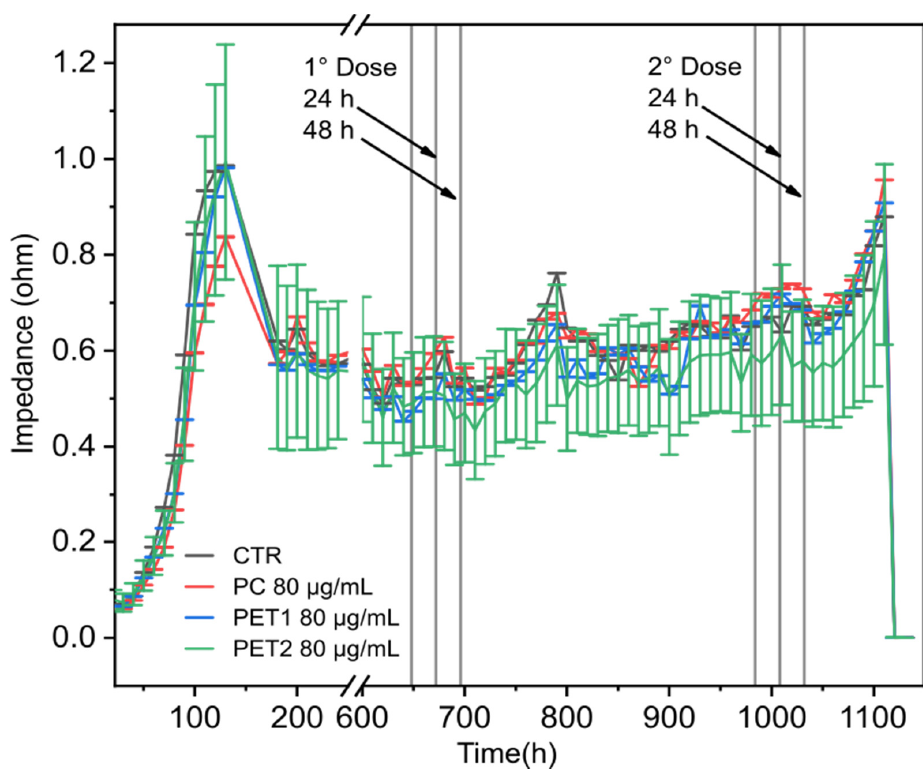
Figure 10. Electrical impedance. Differentiated Caco-2 were exposed to 80 µg/mL of PC, PET1 or PET2 for 48 h; after a recovery period of 12 days, cells were re-exposed to the NPs for another 48 h. At the end of the second treatment, the medium was replaced, and cells were maintained for an additional 48 h. Triton X-100 (0.1%) was then added as positive control.